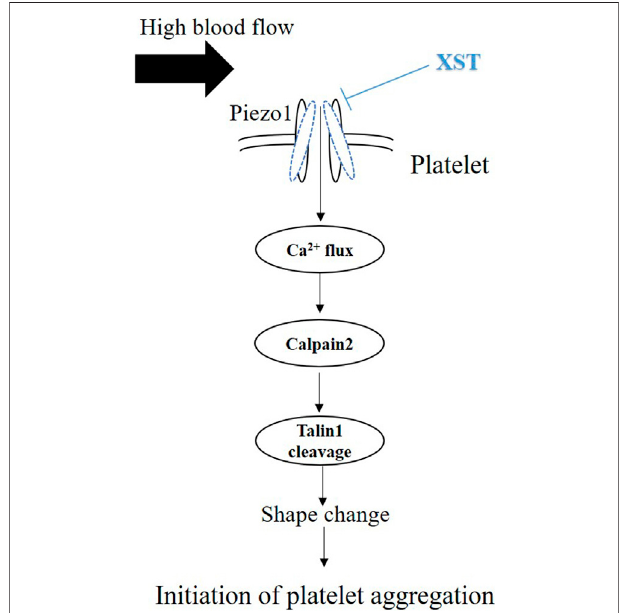
FIGURE 7 | Schematic summary of inhibition by XST of shear-induced platelet aggregation. Exposure to shear activates the Piezo1 channel and ensuing Piezo1-mediated Ca 2+ in fl ux. An increase in intracellular Ca 2+ level in turn stimulates calpain-2 and cleavage of talin1, leading to platelet aggregation. Exposure to high shear rate also upregulates the expression of Pizo1 channel (not depicted here). Treatment with XST at a clinically relevant concentration inhibits shear-induced platelet aggregation via targeting the Piezo1